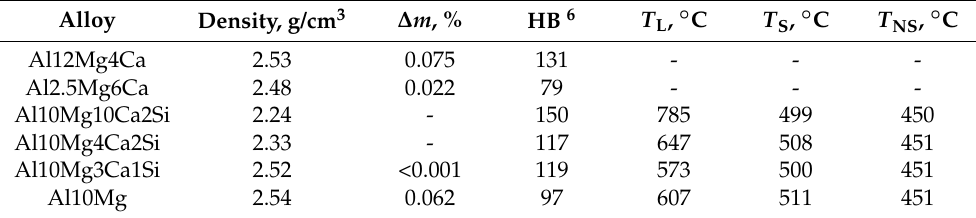
Table 6. Properties of experimental alloys 5